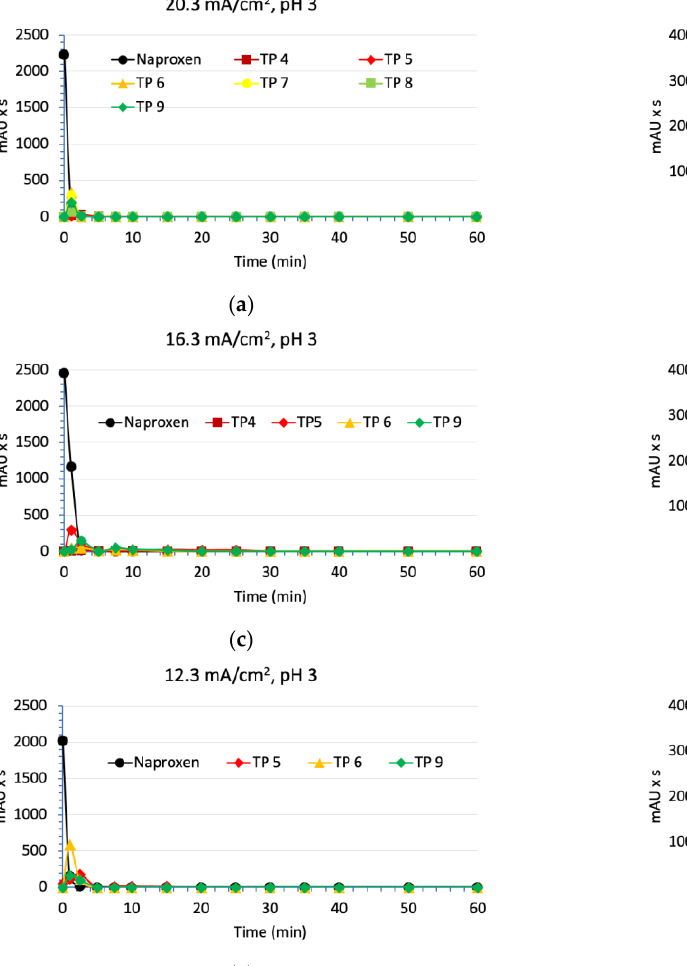
Figure 6. Naproxen transformation products generation and electrochemical oxidation under different current densities and pH conditions. The figure shows the average of three replicates. ( a ) 20.3 mA/cm 2 and pH 3; ( b ) 20.3 mA/cm 2 and pH 9; ( c ) 16.3 mA/cm 2 and pH 3; ( d ) 16.3 mA/cm 2 and pH 9; ( e ) 12.3 mA/cm 2 and pH 3; and ( f ) 12.3 mA/cm 2 and pH 9.